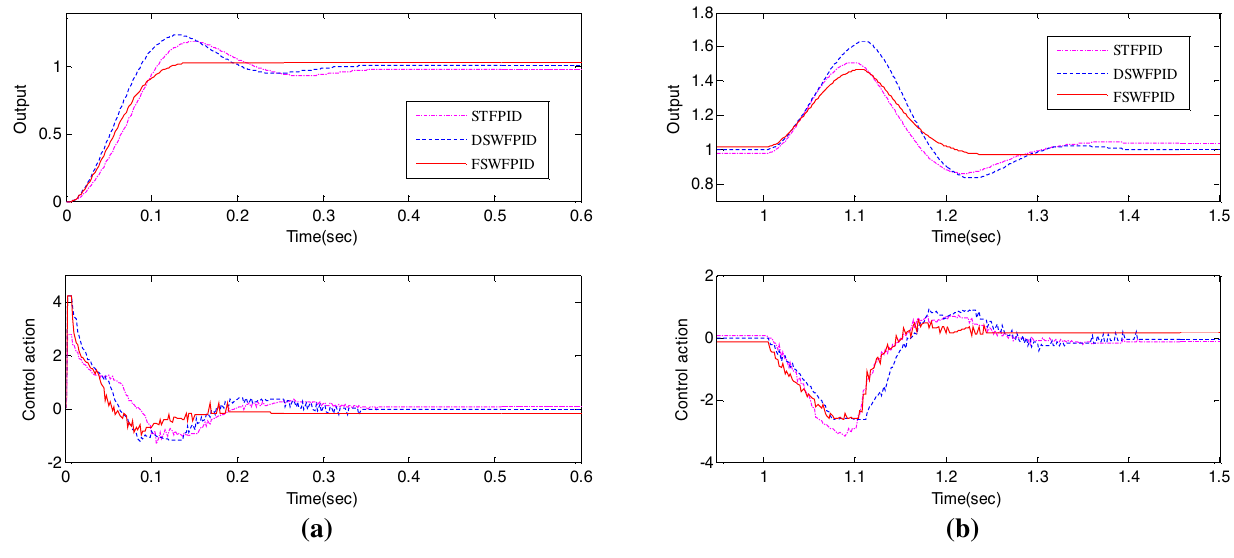
Fig. 26 Responses and control actions for Quanser QUBE-Servo 2 using 25 rules a during set point tracking and b load recovery Table 17 Performance analysis for real-time experimentation with Quanser QUBE-Servo 2